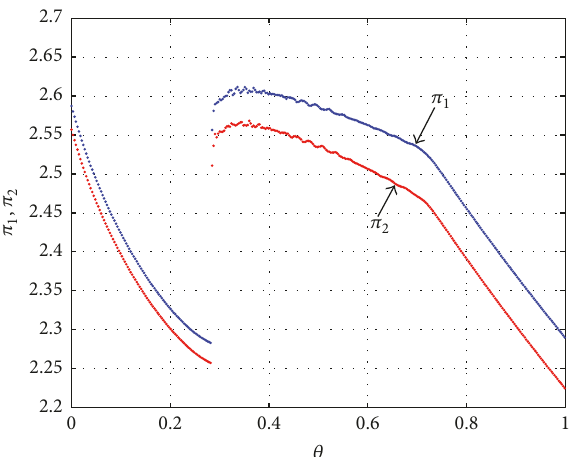
Figure 15: The average profits with respect to 𝜃 when 𝛼 = 0.5 , 𝑤 𝑖 = 0.5 , and 𝛼 1 = 𝛼 2 = 0.25 .